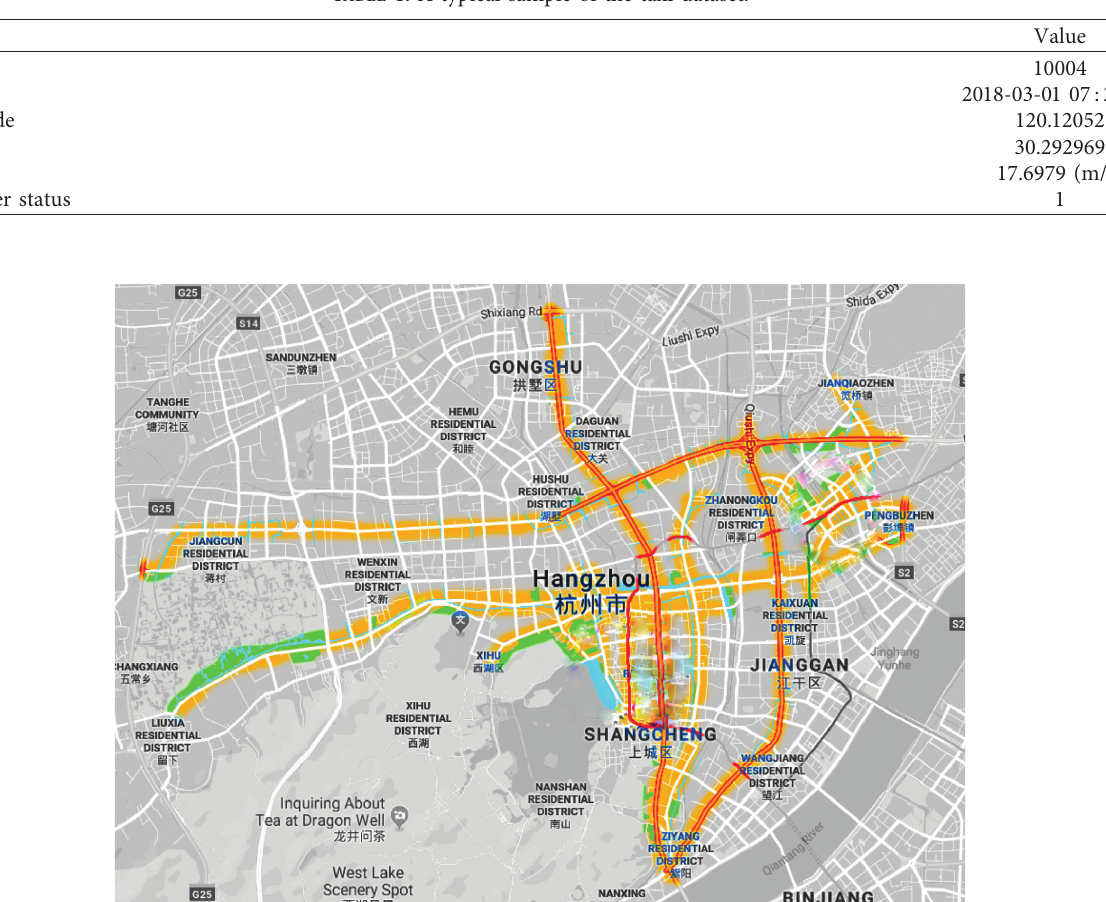
Table 1: A typical sample of the taxi dataset.